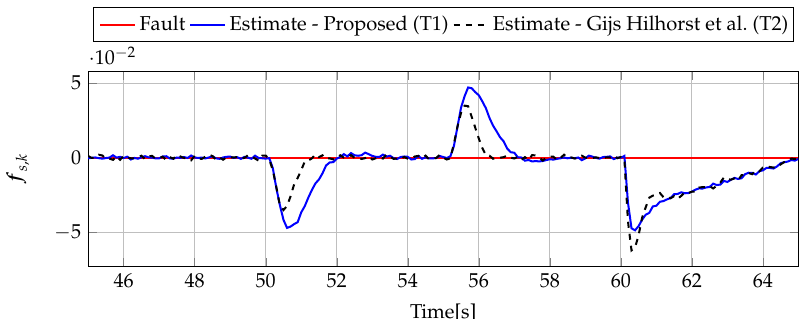
Figure 6. Fault f (red line) and fault estimate obtained with Theorem 1 (T1) and Theorem 2 (T2) s , k based on [39] for FS1 (for t = 45, . . . ,65 [s]) as well as the response for disturbance signal w 1, k